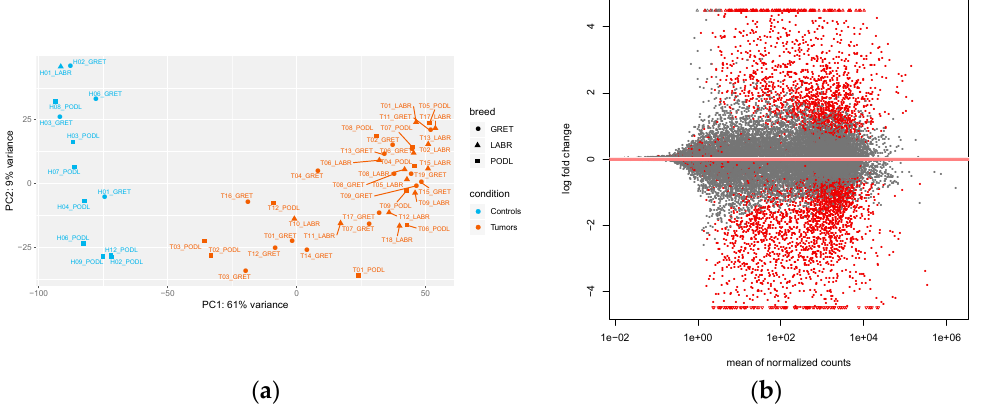
Figure 1. Expression analysis of the 52 oral melanoma samples. ( a ) Principal component analysis (PCA) of the 52 samples, based on gene-normalized counts, with control and tumor samples in blue and orange, respectively; ( b ) M-A plot representing log2-fold gene changes between tumors and controls over the mean of the normalized counts, with red points corresponding to significantly DE genes, with an adjusted p -value < 0.05, and without a log-fold change threshold; genes falling outside of the window are plotted as open triangles.